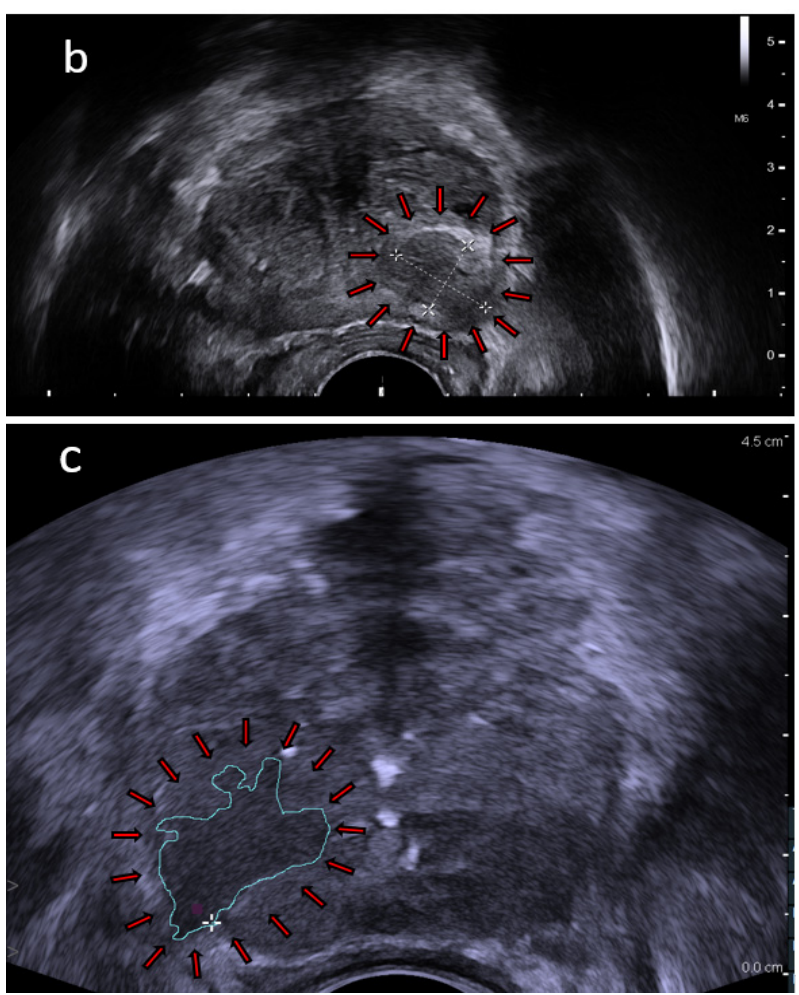
Figure 1. TRUS images: ( a ) prostate with a left side lesion (arrows); ( b ) prostate with a 16 × 12 mm lesion (arrows); and ( c ) prostate with a drawn area of known cancer (arrows). Images provided courtesy of BK Medical.